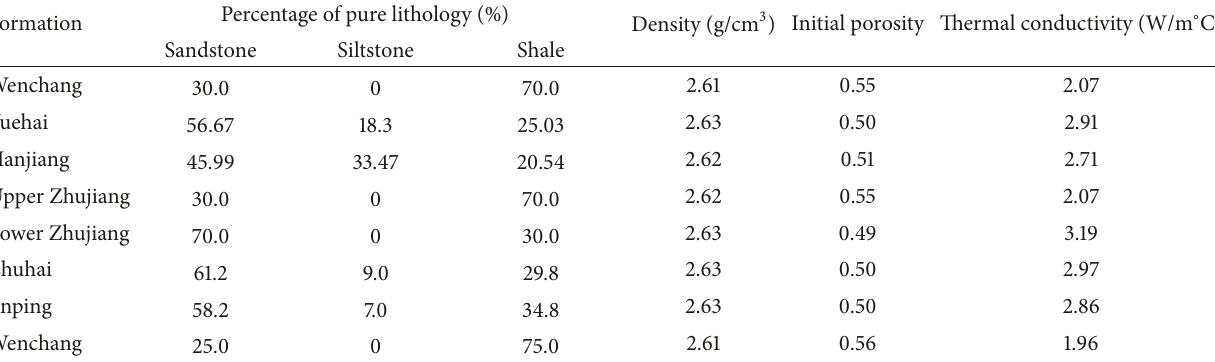
Table 5: Lithology and petrophysical parameters of strata in the Huizhou Sag. Formation Percentage of pure lithology (%) Density (g/cm 3 ) Initial porosity Thermal conductivity (W/m ∘ C) Sandstone Siltstone Shale